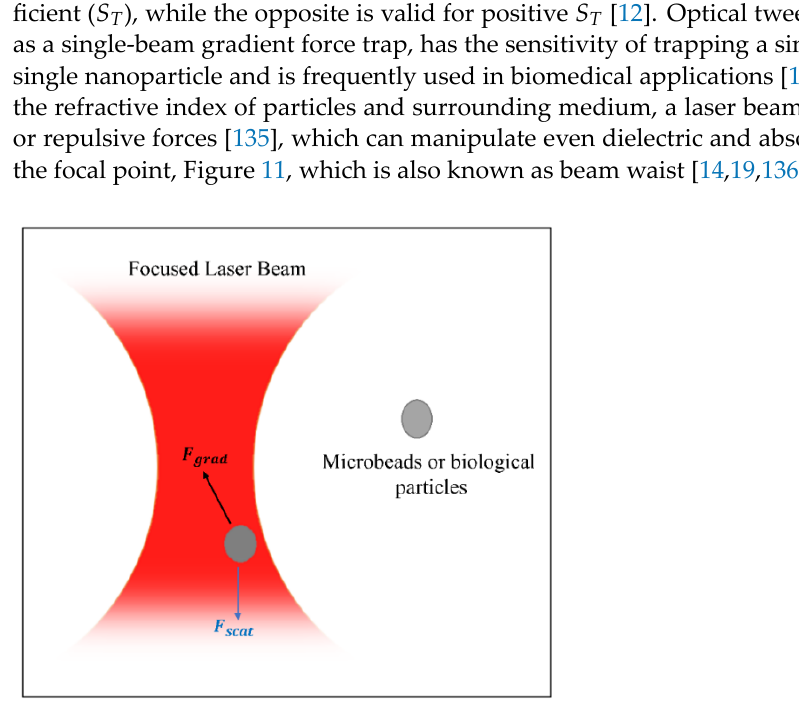
Figure 11. Visualization of single-beam gradient force trapping and forces and the effects of the resulting forces on a particle.